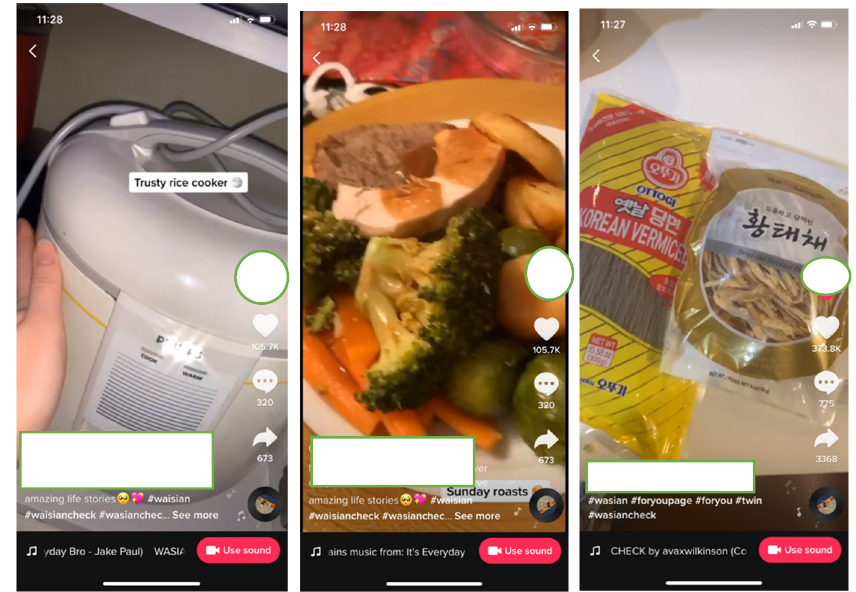
Figure 6. Asian and white food and food related objects.